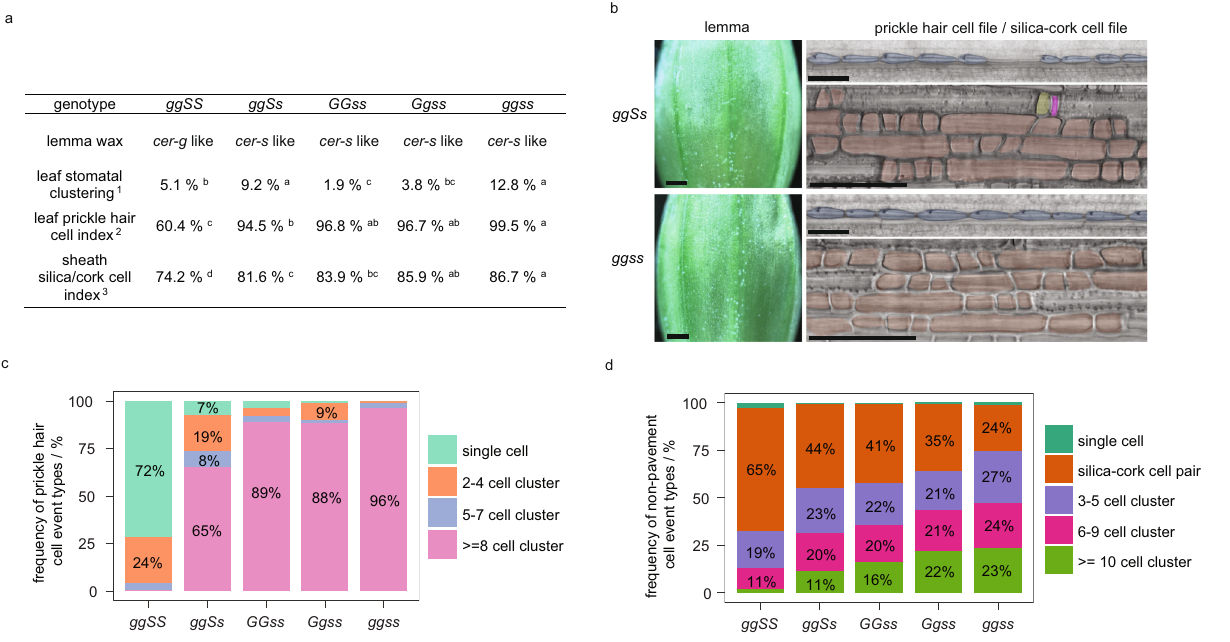
plants per genotype. c Stacked bar graphs numbers show frequency of single and clustered(twotofour, fi vetosevenandgreaterthaneight)pricklecellhaireventsin cer-g.10 / cer-g.10 +/+, cer-g.10 / cer-g.10 cer-s.31 /+, +/+ cer-s.31 / cer-s.31 , cer-g.10 / cer- g.10 cer-s .31/+ and cer-g.10 / cer-g.10 cer-s.31 / cer-s.31 . N =8 plants per genotype. d Stacked bar graphs showing frequency of normal silica – cork cell pair and abnor- malcellpatterning(singlecell,clusterofthreeto fi ve,sixtonineandgreaterthanten non-pavement cells) events in costal (over vasculature) fi les of cer-g.10 / cer-g.10 +/+, cer-g.10 / cer-g.10 cer-s.31 /+, +/+ cer-s.31 / cer-s.31 , cer-g.10 / cer-g.10 cer-s .31/+ and cer- g.10 / cer-g.10 cer-s.31 / cer-s.31 leaf sheaths. N =8 plants per genotype. Source data, including p values of statistic tests of a , c and d are provided in the Source data fi